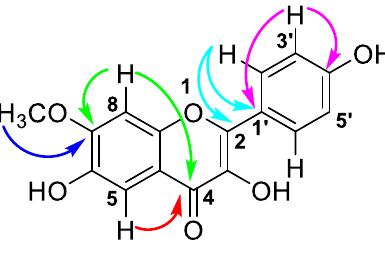
Figure 5. HMBC correlations of the flavonol.